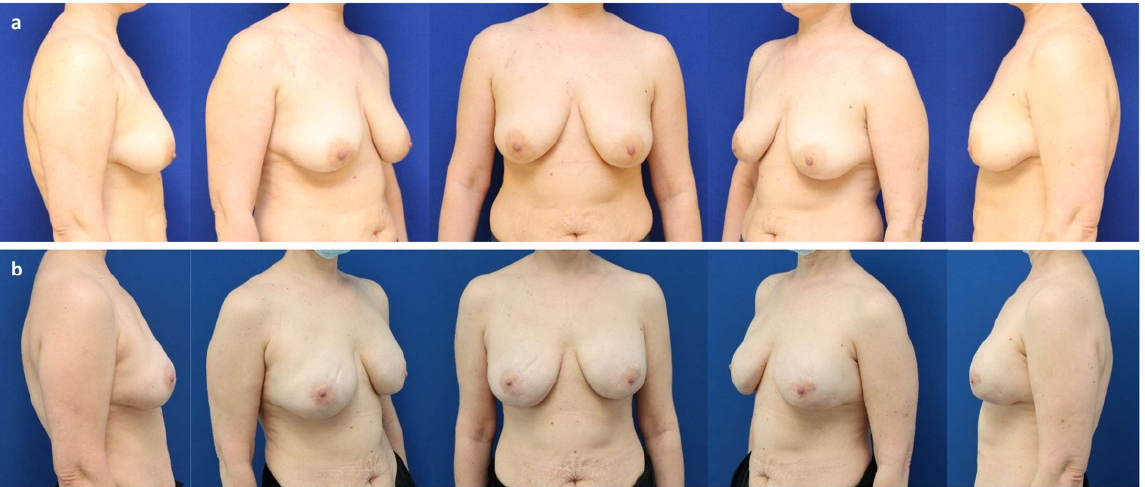
Figure 1. ( a ) A 41-year-old patient with invasive-ductal carcinoma (pT2 pN1a (3/3) M0) of the left breast and a BRCA-1 mutation after neo-adjuvant chemotherapy with mild volume asymmetry and breast ptosis grade II (Regnault classification). ( b ) Six years after the bilateral nipple sparing mastectomy and immediate subpectoral implant-based breast reconstruction (Motiva Ergonomix ® ERSD 475 cc, Establishment Labs Motiva, Alajuela, Costa Rica) and ADM (Strattice™ tissue matrix, LifeCell Corporation; Branchburg, NJ, USA) through a periareolar access with lateral extension to correct the ptosis and adjuvant radiotherapy of the left breast. Note the rippling of the right breast (upper inner quadrant), skin retraction, and capsular contraction grade II (Baker classification) of the left breast.